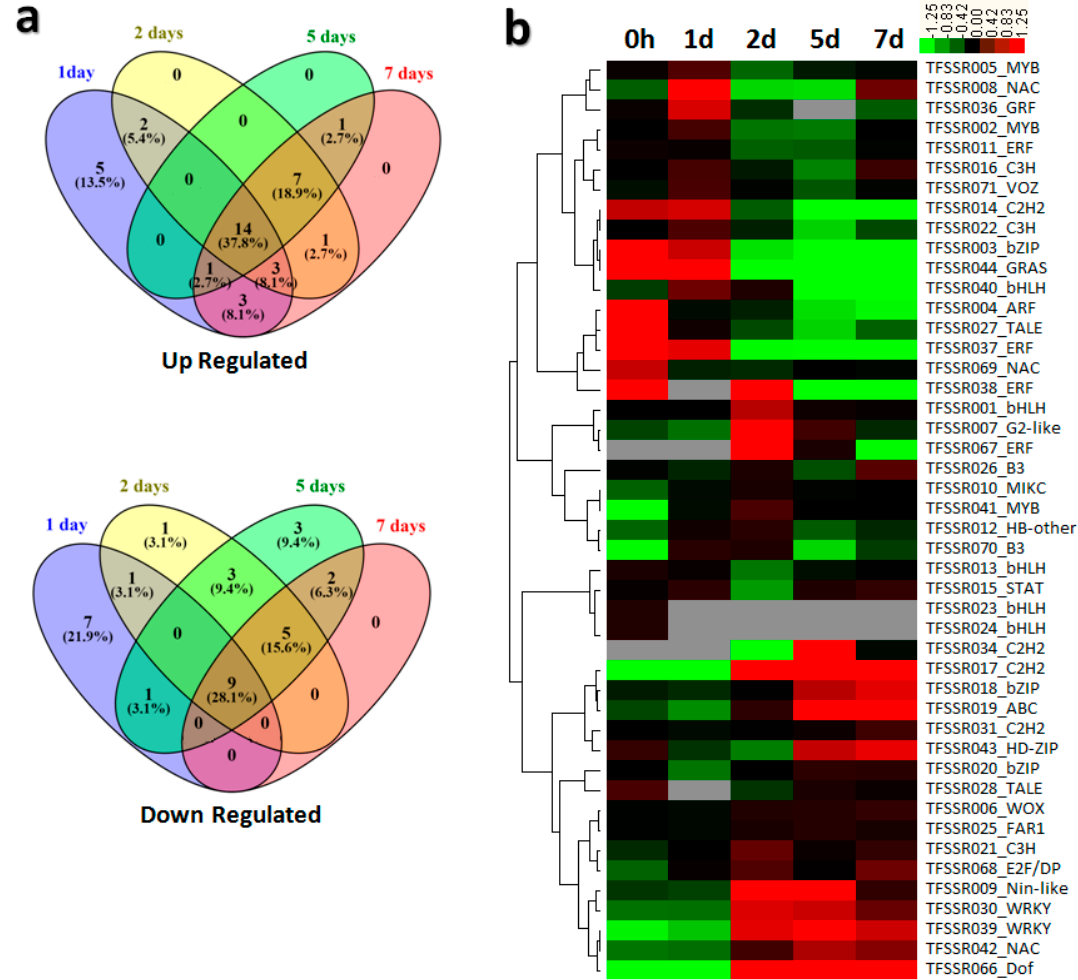
Figure 2. Summary of differential expression of TFSSR-associated genes in response to biotic stress. ( a ) Venn diagram represents time-course specific distribution of TFSSR-associated gene expression among up- and down-regulated categories; ( b ) Heat map showing hierarchical cluster analysis based on the log 2 fragments per kilobase of transcript per million mapped reads(FPKM) values.